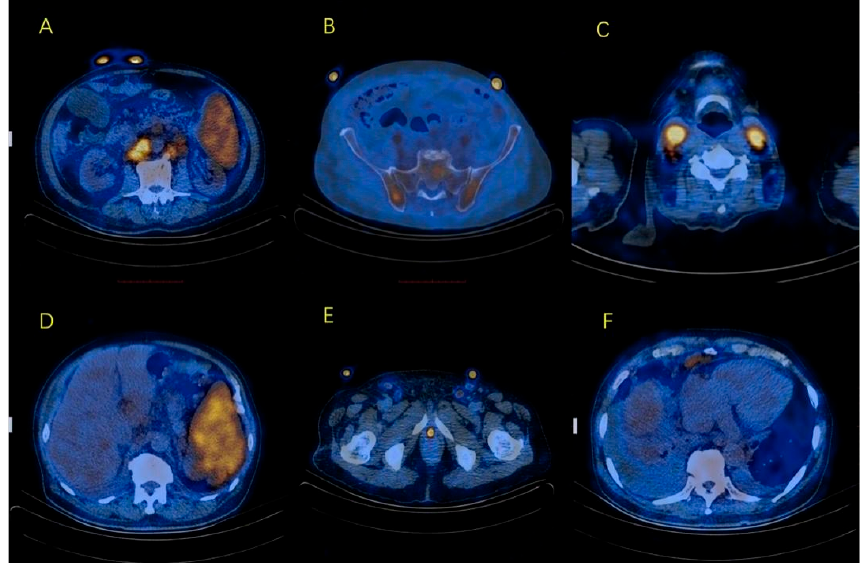
Figure 1. PET/CT showed enlargement of multiple lymph nodes with increased glucose metabolism. ( A ) enlarged retroperitoneal lymph nodes; ( B ) slightly increased glucose metabolism of the pelvis with no bone destruction; ( C ) enlarged cervical lymph nodes; ( D ) splenomegaly with increased glucose metabolism; ( E ) enlargement of bilateral inguinal lymph nodes; ( F ) enlarged lymph nodes in cardiophrenic